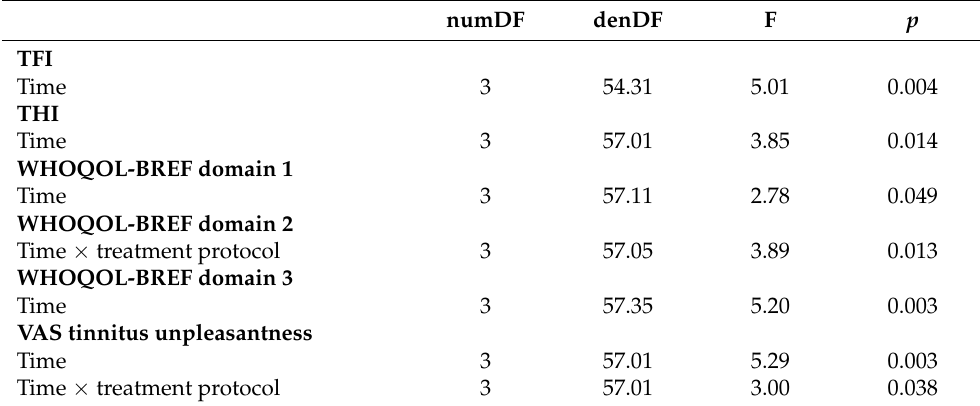
Table A2. Fixed effect testing.